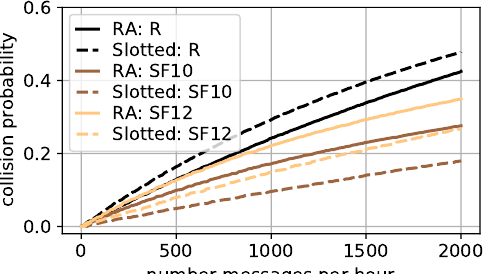
Figure A1. Collision probability for different random access (RA) and slotted ALOHA (Slotted)